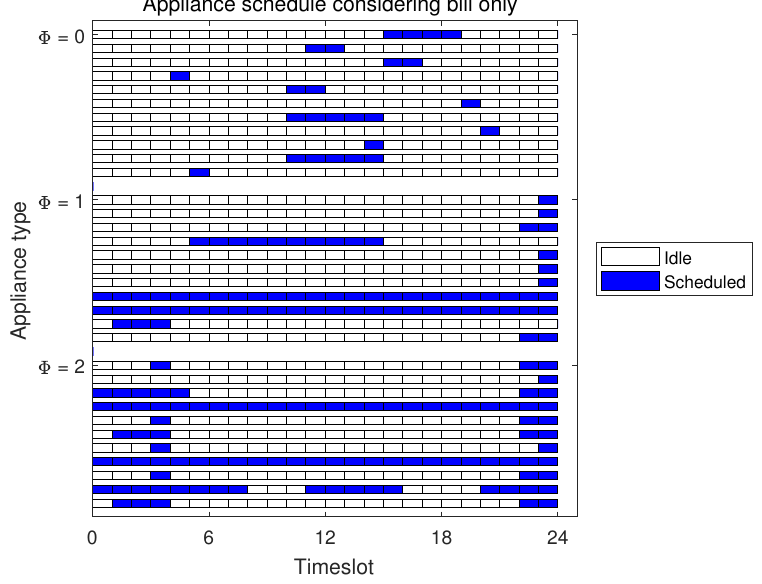
Figure 11. Scheduling results of appliance vs. timeslot considering only the electricity bill.